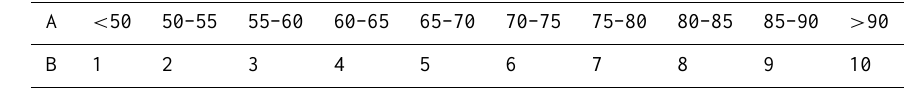
Table 3. The influence level ranking orders of water from the Changjiang’s upper reach.